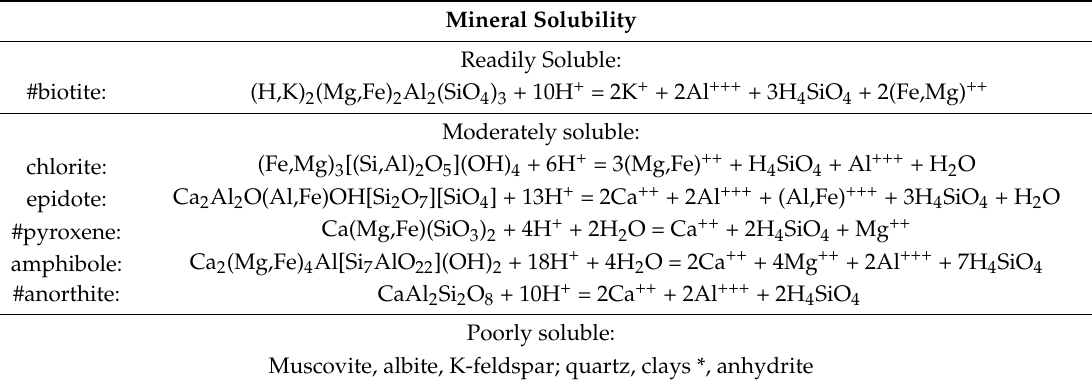
Table 4. Proposed relative reactivity of important gangue silicates commonly encountered in porphyry copper deposits, under heap leaching